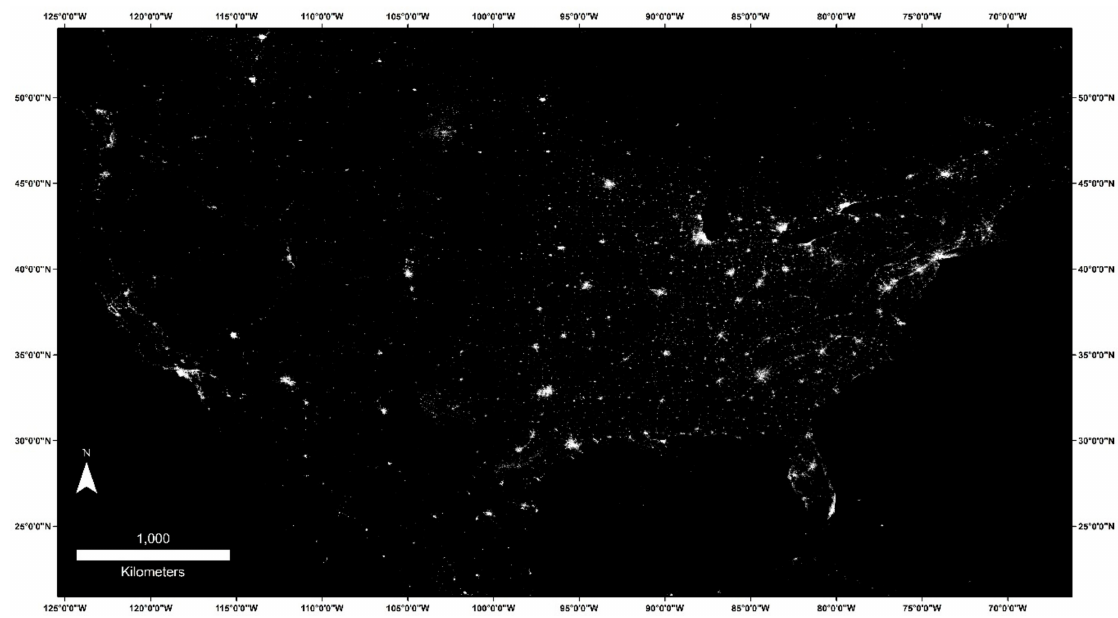
Figure 2. Night lights according to masked average radiance from the V.2 VNL,